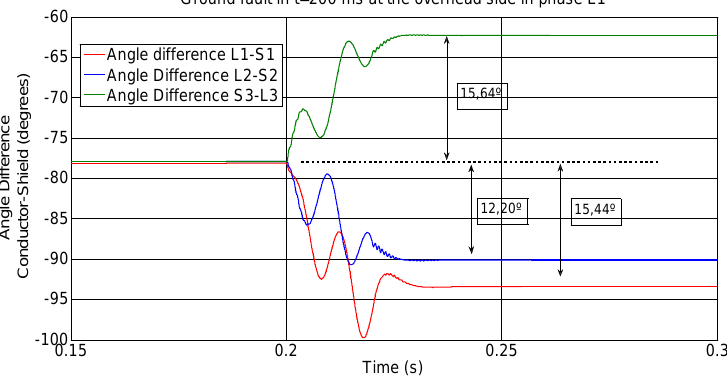
Figure 10. Angular differences with ground fault at the overhead side in phase L1.